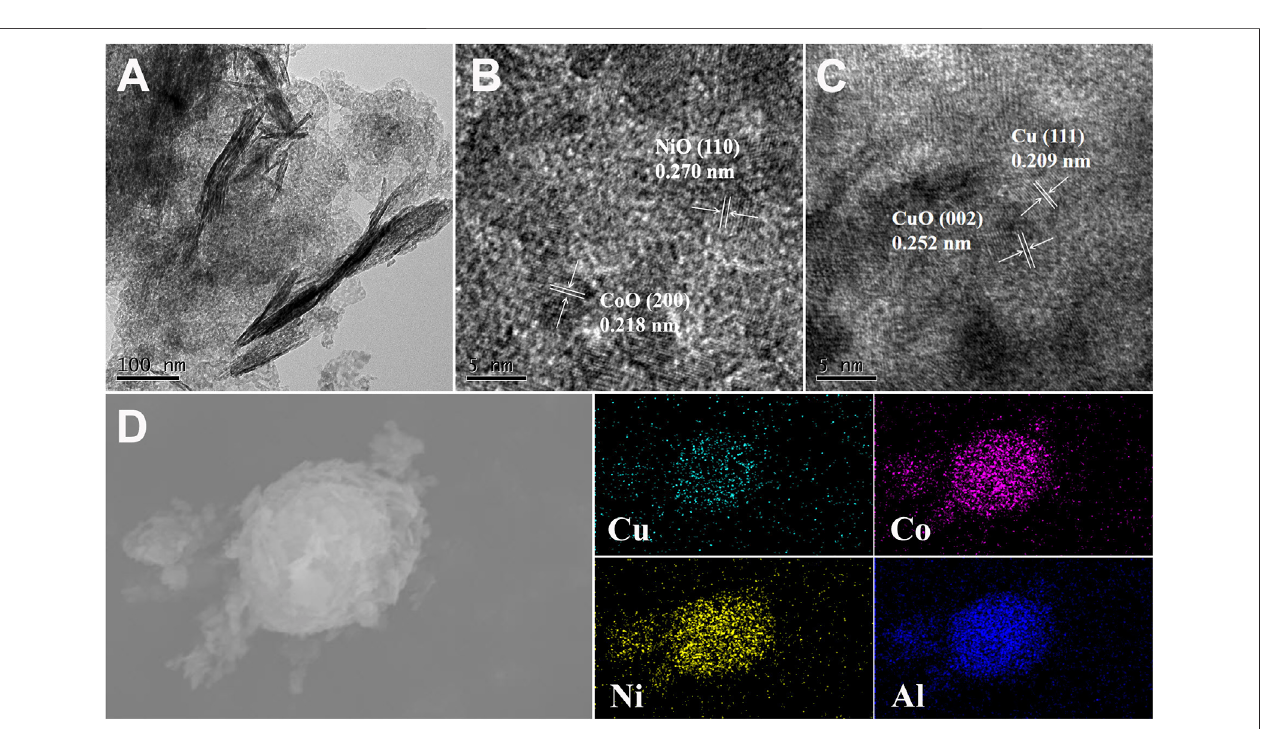
Frontiers in Chemistry |